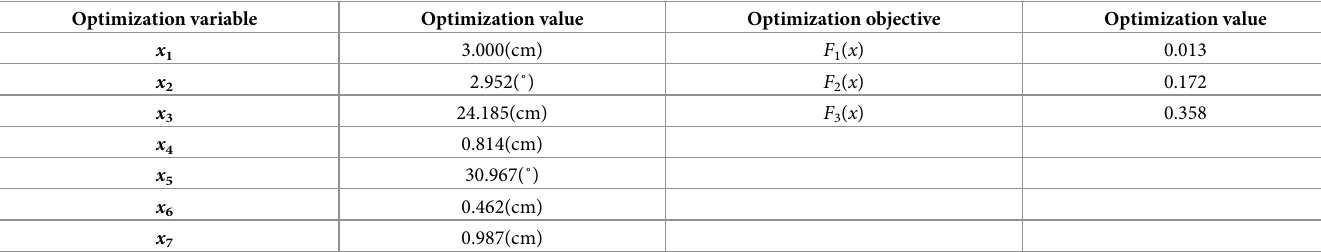
Table 5. NSGA-II multiobjective genetic algorithm optimization results. Optimization